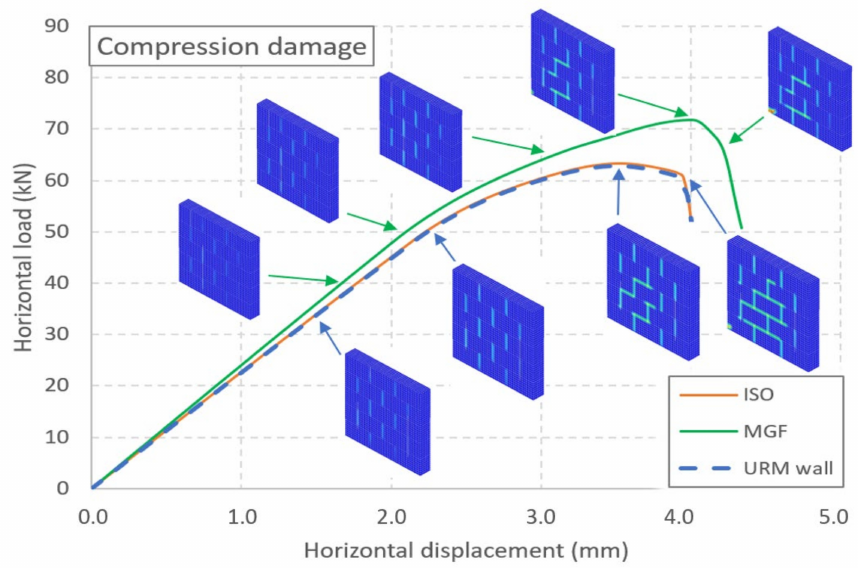
Figure 10. Numerical force vs. displacement curves for the three types of wall and the evolution of the damage under compression for the URM and MGF walls.